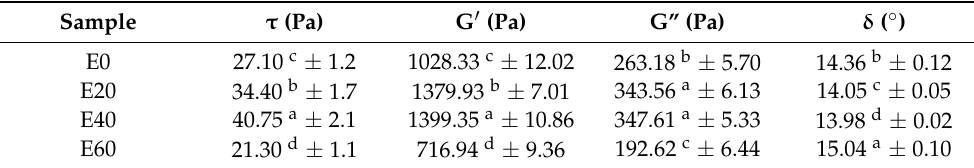
Table 2. The effect of erythritol on the yield stress (Pa), storage modulus (Pa), loss modulus (Pa), and phase angle ( ◦ ) values of the macaron batters before